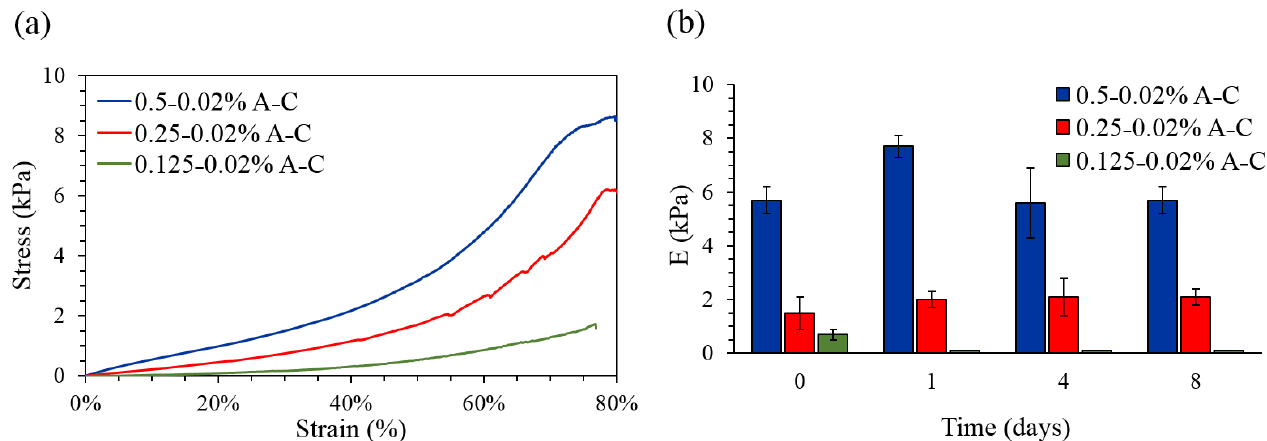
Figure 3. ( a ) Representative stress-strain curves of the A-C hydrogels subjected to unconfined compression with a dis- placement rate of 0.01 mm/s, until 80% strain. ( b ) Compressive moduli of the A-C hydrogels after 0, 1, 4, and 8 days of incubation in PBS at 37 °C, in humified atmosphere with 5% CO 2 .